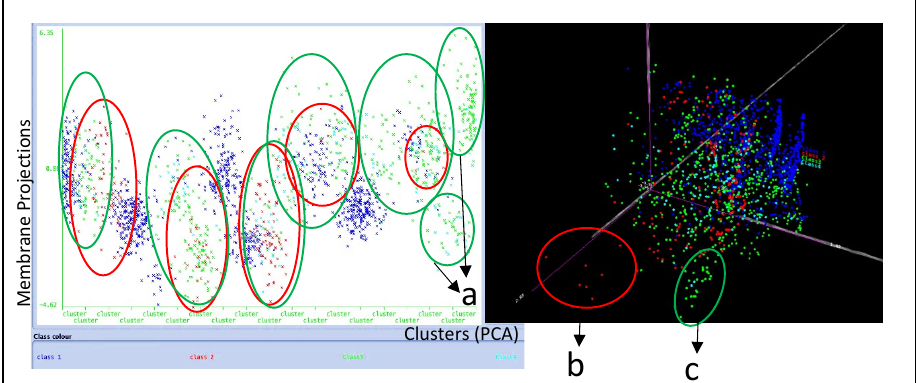
Figure 7. ( a ) Membrane projections of 19 different clusters: 14 of the clusters were dominated by class 3 exosomes, which are more mobile and dynamic. Seven different static exosomes; ( b , c ) distinct dynamic exosome morphologies were noticed using